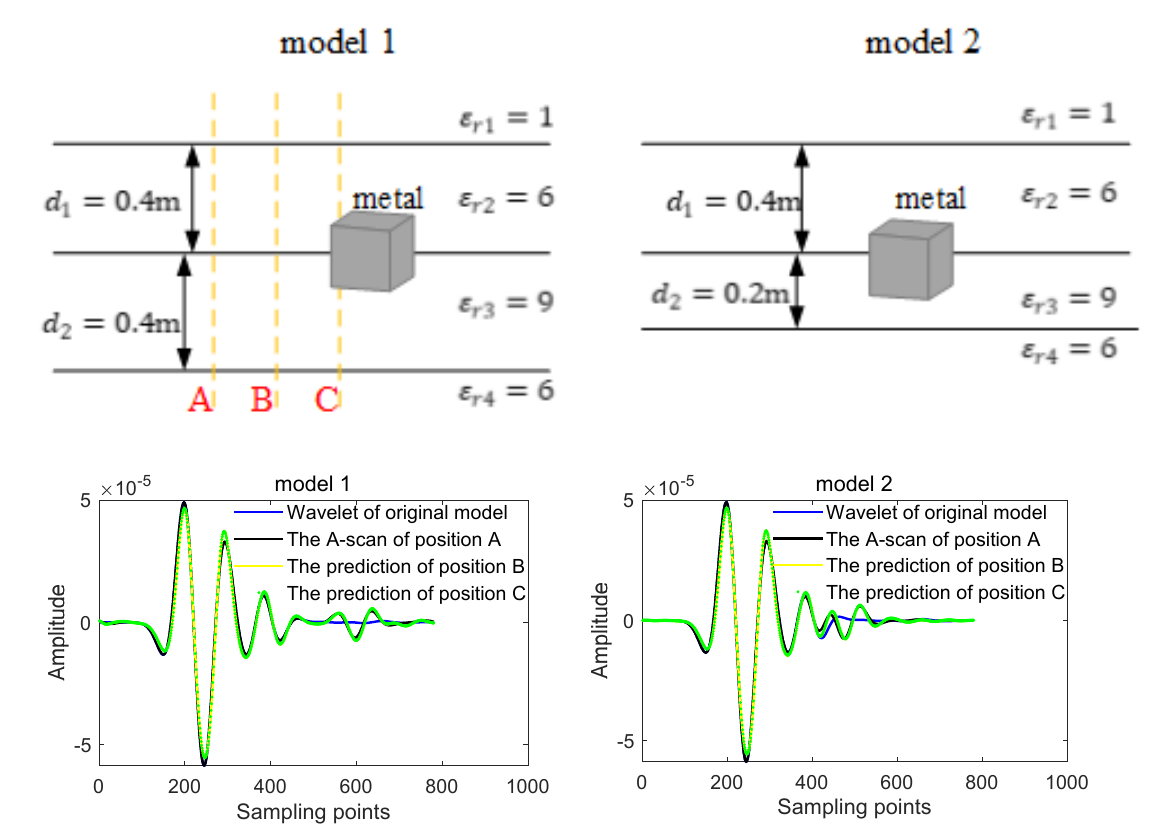
Figure 10. Wavelet prediction results of derived models 1–2.